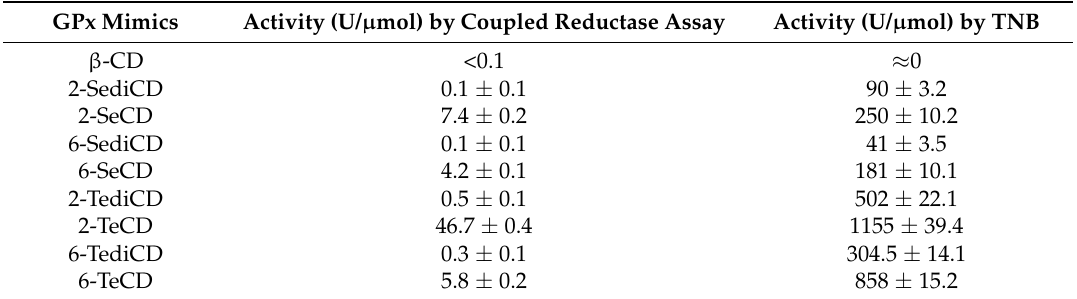
Table 1. Enzyme activity was measured by a coupled reductase assay and TNB reaction assay. GPx